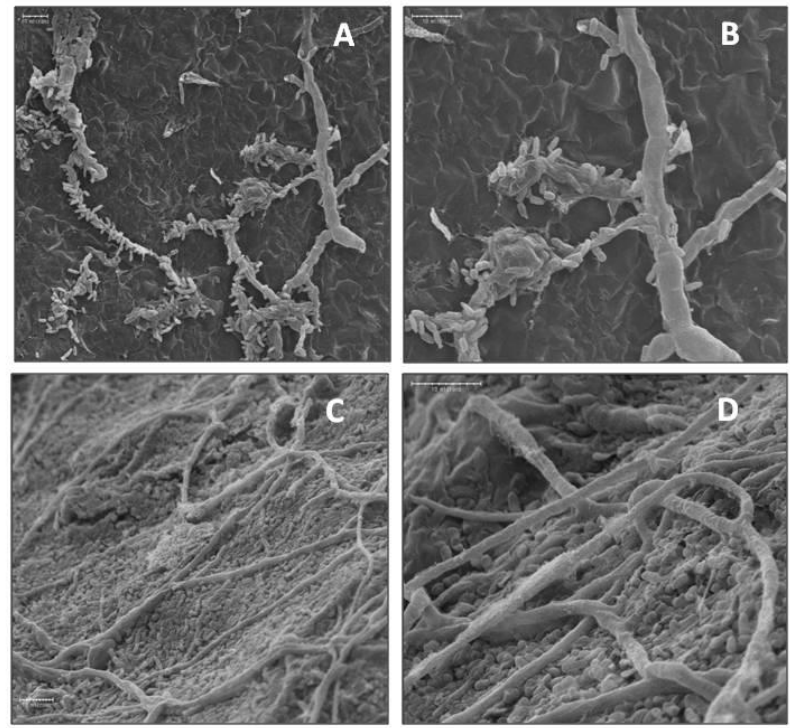
Figure 4. Scanning electron micrographs of biocontrol bacterial cells interacting with hyphae of C. acutatum in apple wounds four days after inoculation. ( A ) Attachment of biocontrol isolate A3-6 cells to hyphae of C. acutatum at 750×. ( B ) Attachment and degradation of C. acutatum hyphae by isolate A3-6 at 1500×. ( C ) Isolate Ae-1 in fruit wounds at 1000× and ( D ) 2000×.